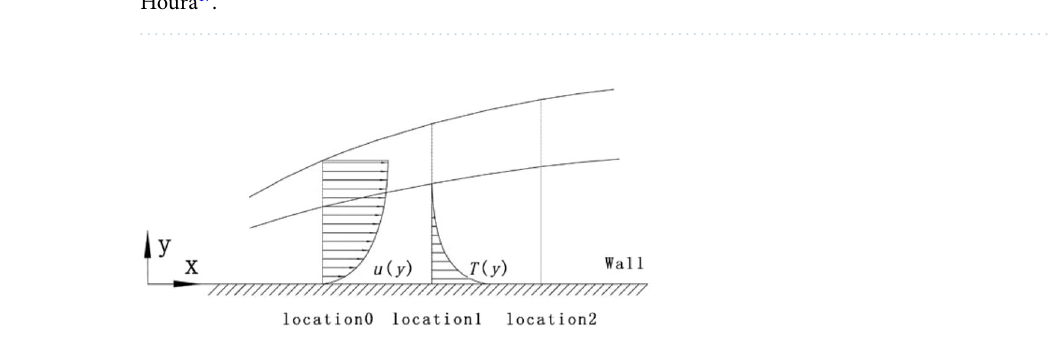
Figure 7. Schematic diagram of the velocity and thermal boundary